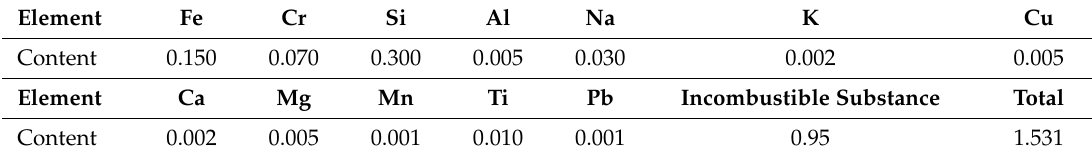
Figure 6. Transmission electron microscopy images of nanodiamond powder (300,000 × ). Table 4. Contents of impurity elements in ultradispersed nanodiamond powder (% by mass).